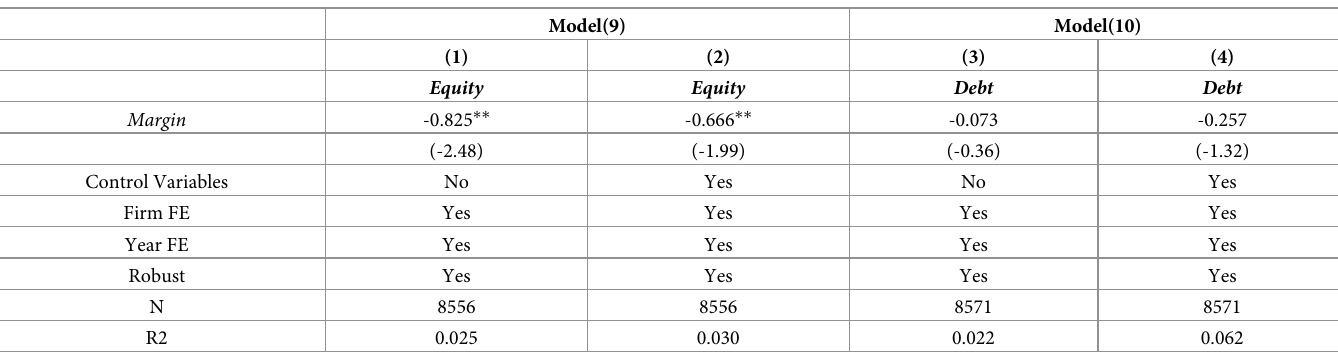
Table 16. Impact of margin trading on external equity